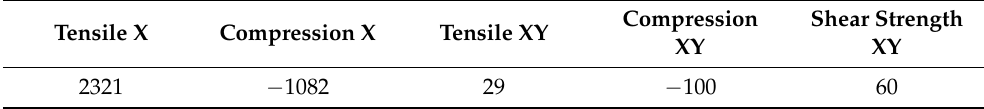
Table A3. UD composite failure stresses